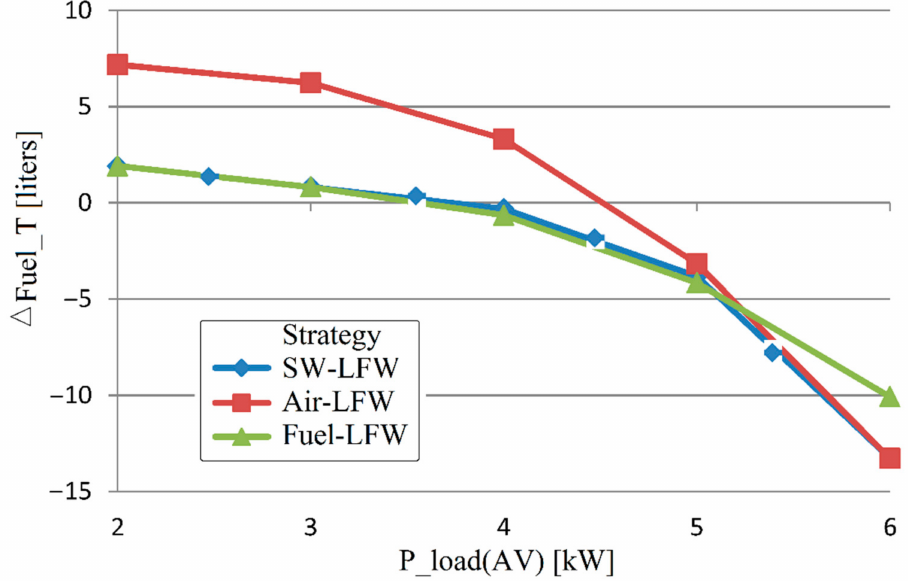
Figure 5. Fuel economy using different P load(AV) values for the first load